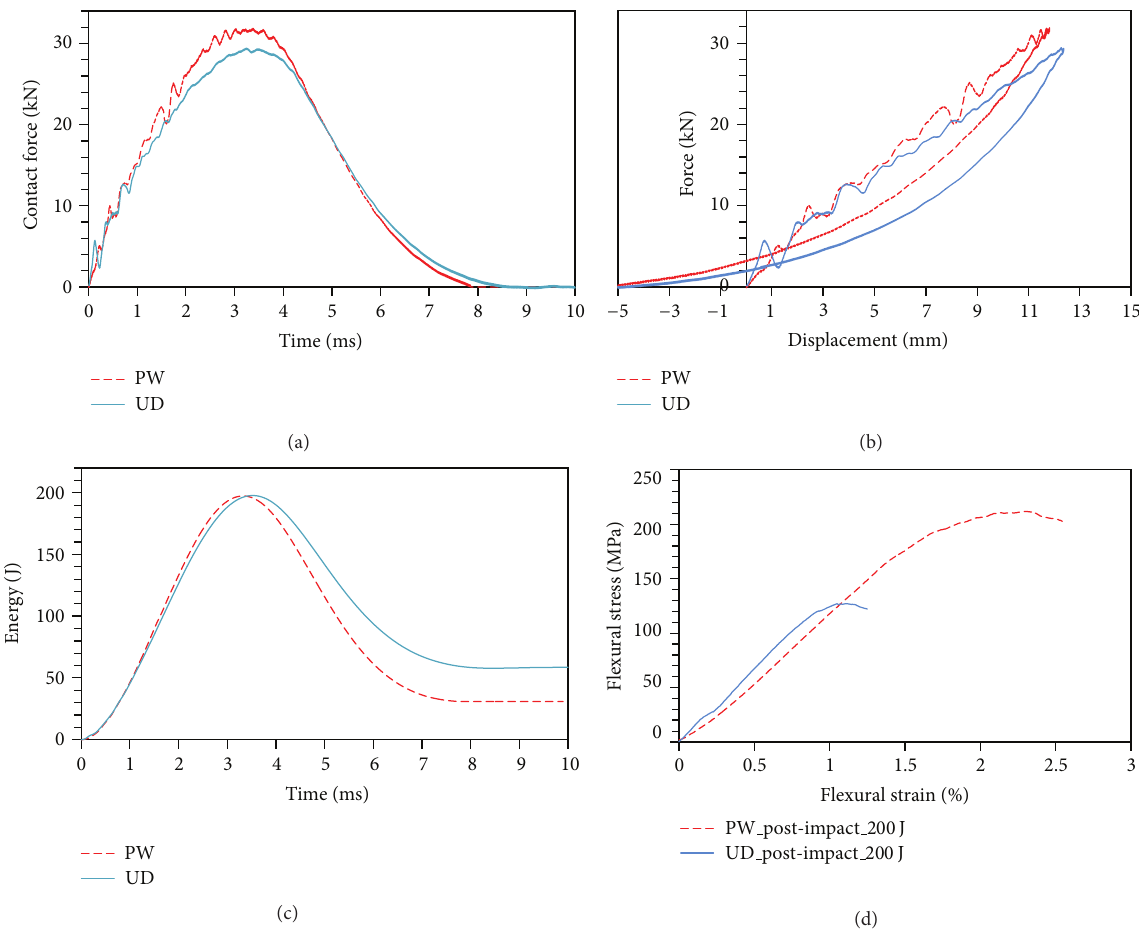
Figure 6: The average response curves of PW and UD samples subjected to 200 J impact loading; (a) impactor force versus time, (b) force versus displacement, (c) energy versus time, and (d) the postimpact flexural test results.